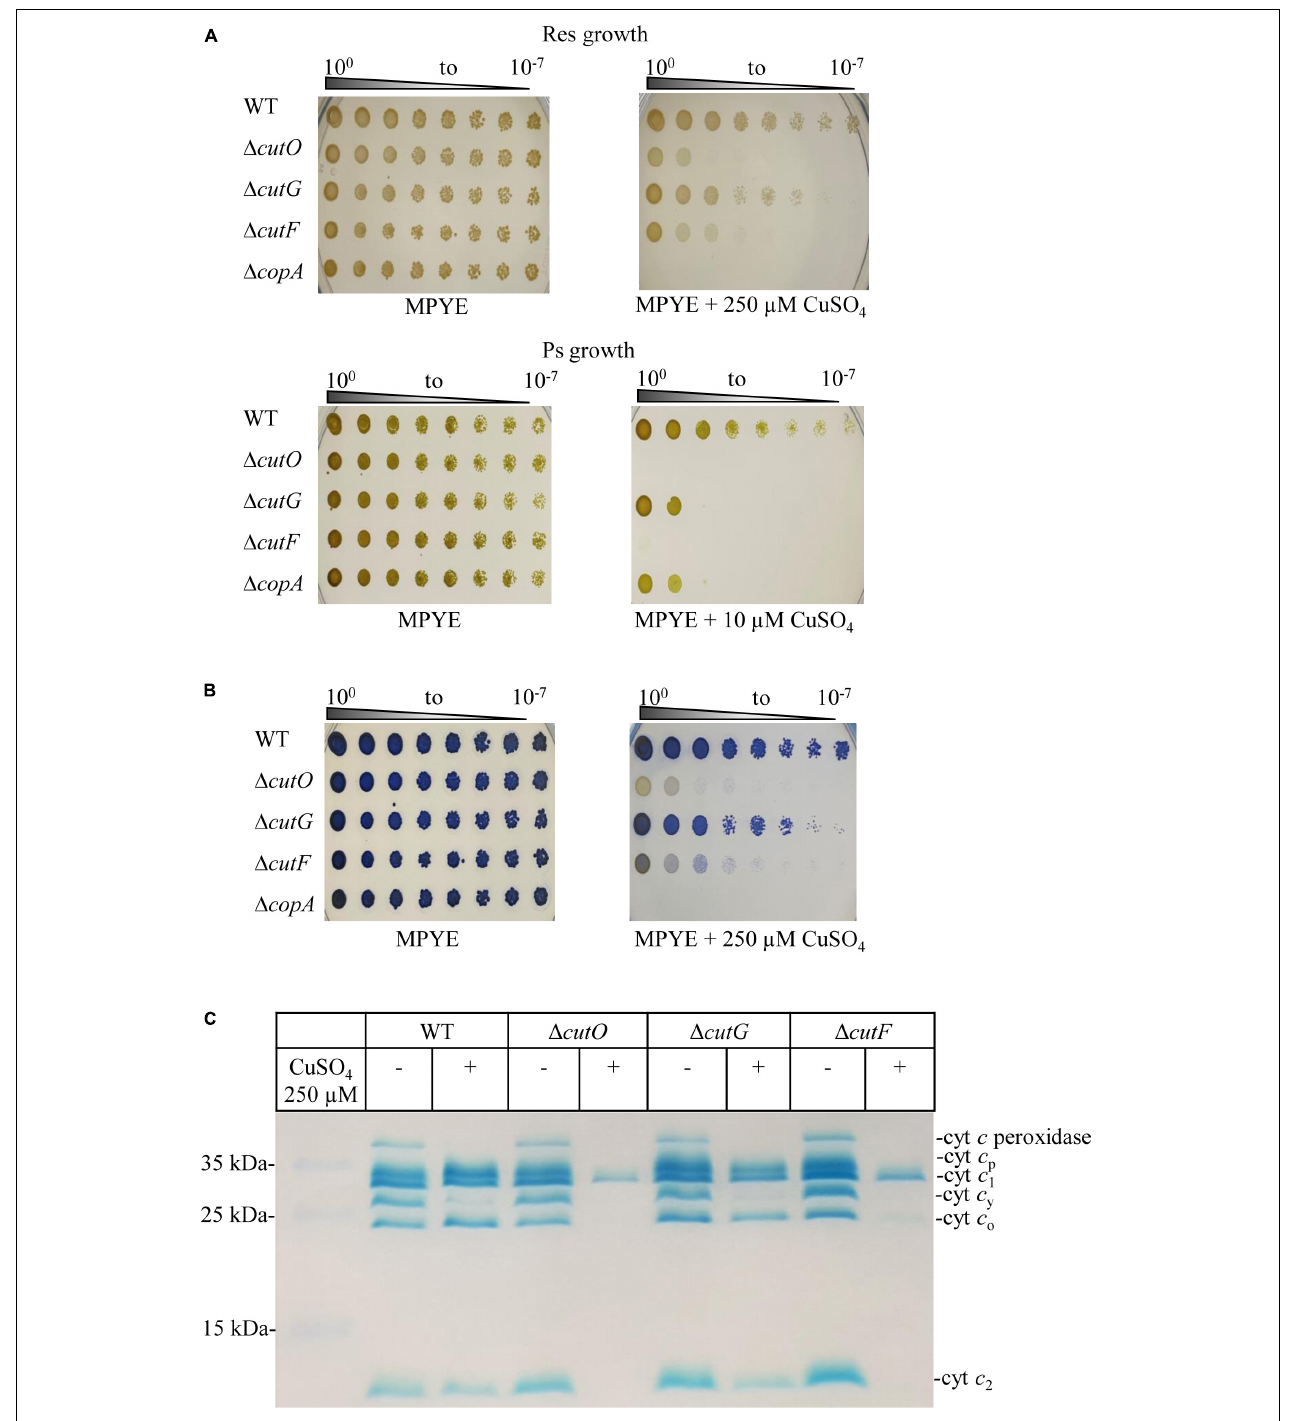
FIGURE 2 | Copper (Cu) sensitivity assay and cytochrome c profiles of the cutF , cutO , and cutG knockout strains of R. capsulatus . (A) WT and the indicated knockout strains were serially diluted and growth was tested on MPYE agar plates supplemented with 10 or 250 µ M CuSO 4 for photosynthetic and respiratory growth, respectively, and incubated under appropriate growth conditions for 2–3 days. As a control, the (cid:49) cop A strain lacking the Cu-exporting P 1B -type ATPase CopA was included. (B) The cbb 3 -Cox activities of the indicated strains grown under respiratory conditions on MPYE + 250 µ M CuSO 4 were determined by the NADI reaction. The blue dye indophenol blue is formed within 45 s in the presence of active cbb 3 -Cox. No or very low cytochrome c oxidase activities were observed for the (cid:49) cutO and (cid:49) cutF strains in the presence of 250 µ M Cu. (C) The c -type cytochrome profiles of mutant strains grown in the presence and absence of supplemented CuSO 4 were determined by heme-staining of isolated membranes and after separation on 16.5% SDS-PAGE. Cyt c p and cyt c o correspond to the subunits of cbb 3 -Cox, cyt c 1 is the subunit of cyt bc 1 complex, and cyt c y and cyt c 2 , correspond to membrane-bound and soluble electron carriers, respectively.